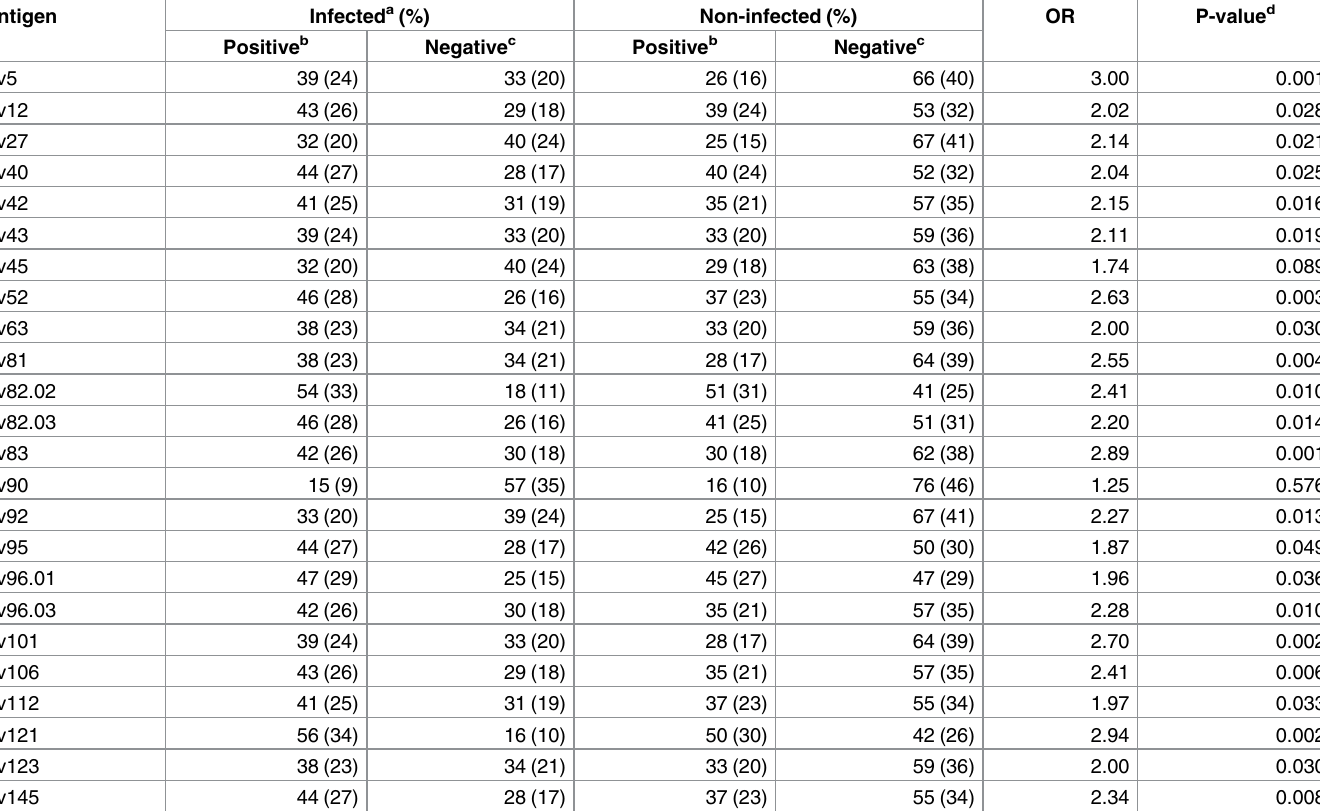
Table 3. Reactivity of antibodies at enrollment based on status of